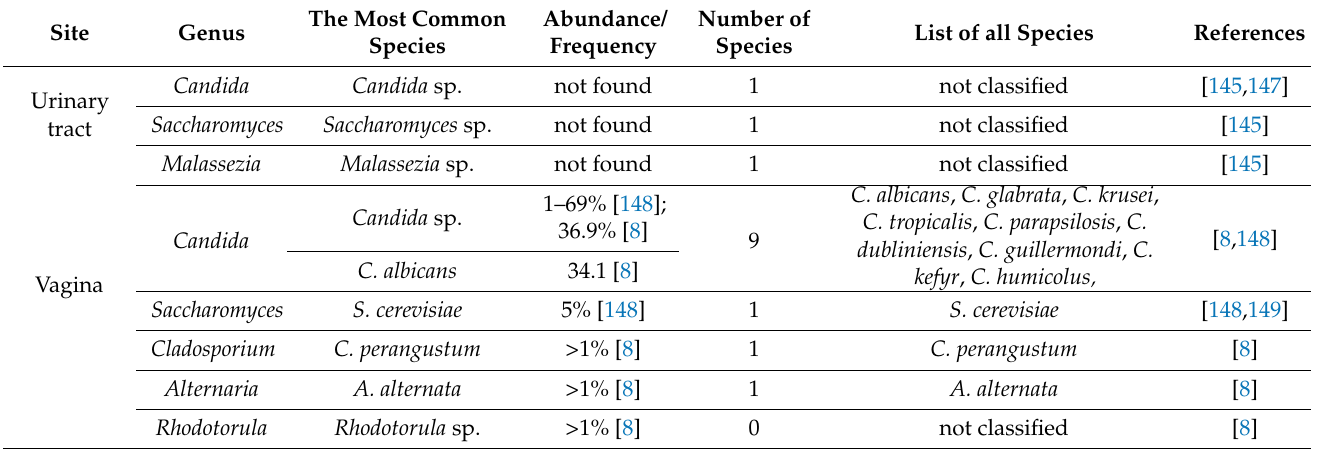
Table 7. The list of chosen genitourinary tract mycobiome colonizers. The table summarizes the rela- tive abundance (or frequency) of representative taxa, number and summary of all species described in the